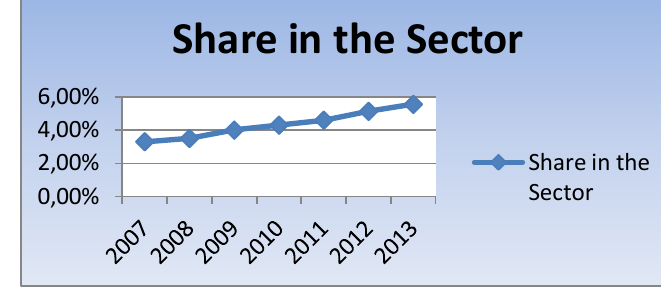
Table-17: Growth of Total Assets in Deposit Banks, 2007- 2013